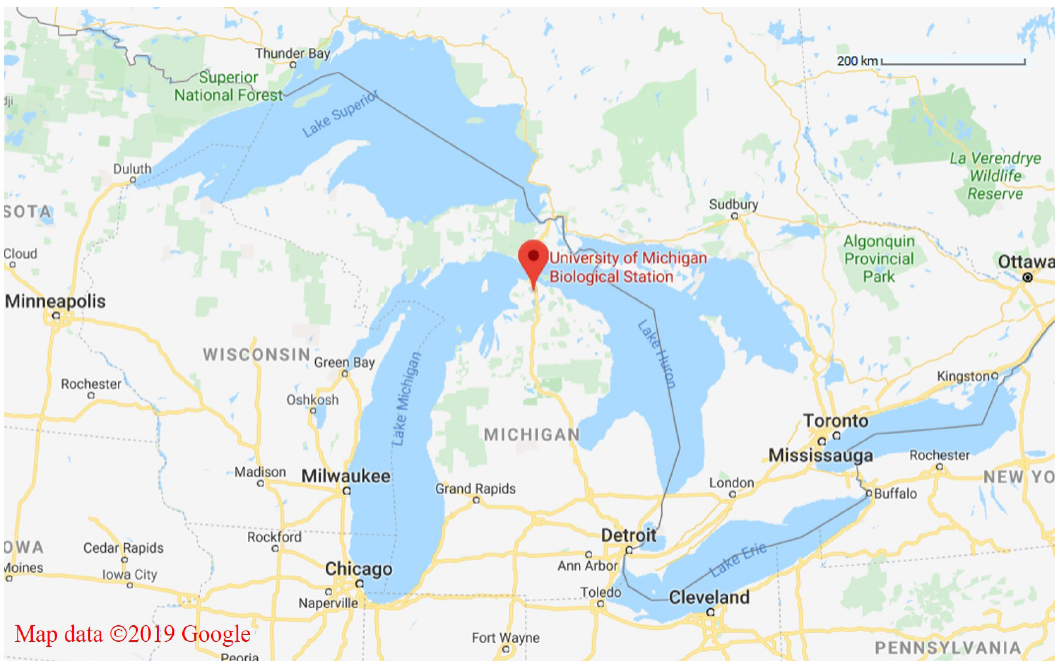
Figure 1. Location of the University of Michigan Biological Station (45.56 ◦ N, 84.71 ◦ W), indicated by the red pin on the map. The map scale is shown in the upper right corner (map data © 2019